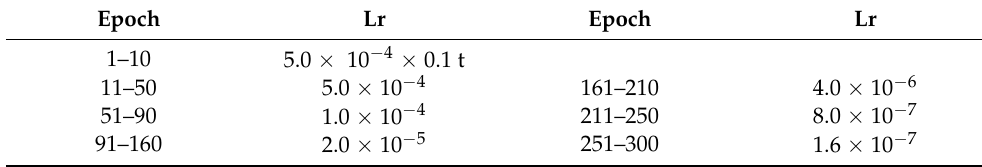
Table 1. The setting of learning rate.